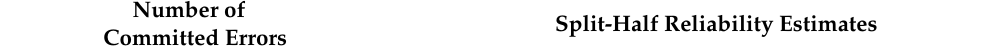
Table 1. Descriptive statistics and split-half reliability estimates for the number of PE, SLE, and IE. SD = standard deviation; HDI = highest density interval.